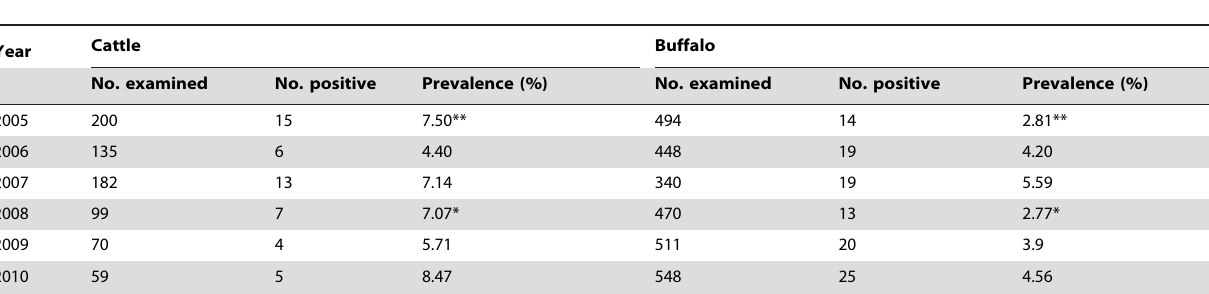
Table 2. Prevalence of S. japonicum infection in cattle and buffalo from Nandashan Town.